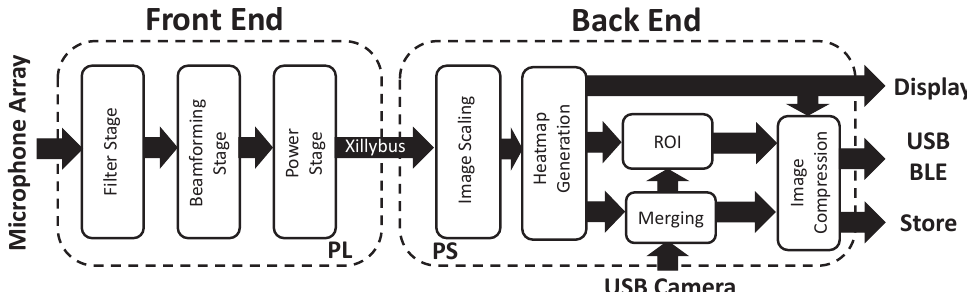
Figure 1. Distribution of the components into the Zynq 7020